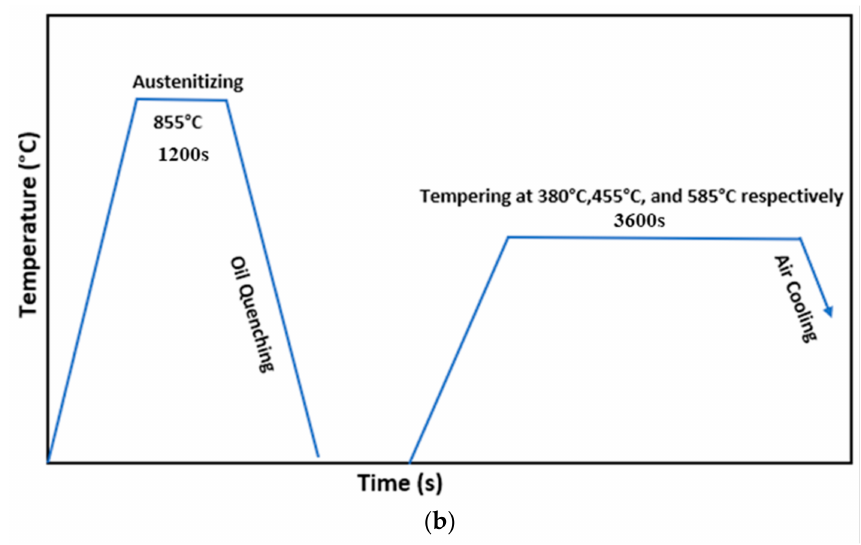
Figure 2. Schematic description of ( a ) austempering process, and ( b ) quenching-tempering